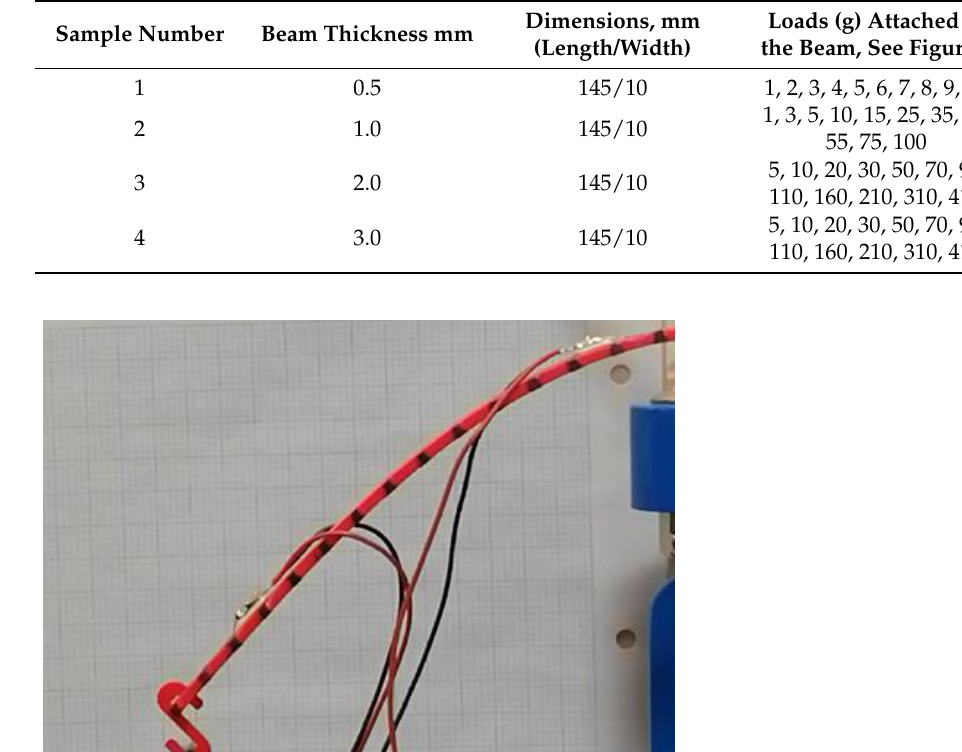
Table 3. Experimental setup for simple beam. Table 2. Experimental setup for simple beam.